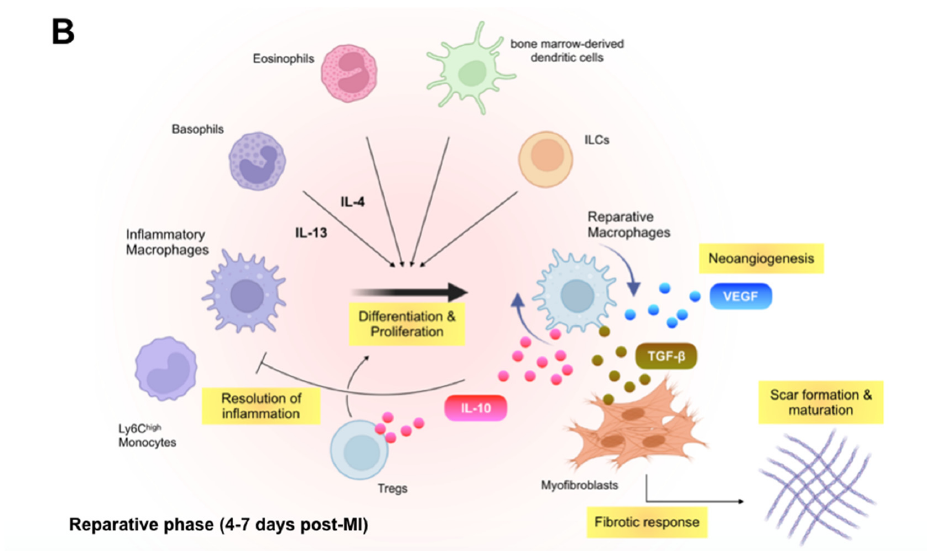
Figure 1. Immune inflammatory response within the infarcted heart. ( A ): Shortly after the onset of myocardial infarction (MI), endogenous damage-associated molecular patterns (DAMPs) released from necrotic cardiomyocytes and other injured cells stimulate surviving resident cells and recruited immune cells to produce inflammatory cytokines, chemokines, and proteases (e.g., interleukin [IL]-1 β , C-C motif chemokine ligand 2 [CCL2], and matrix metalloproteinases), which initiate innate immune response. Inflammatory macrophages scavenge dying cardiomyocyte-derived DNA fragments to activate interferon regulatory factor 3 (IRF3)-dependent type I interferon (IFN) signals that enhance infarct inflammation. Cardiac fibroblasts produce and release granulocyte-macrophage colony-stimulating factor (GM-CSF) in response to the engagement of their pattern recognition receptors (PRRs), which not only endows monocytes and macrophages with a pro-inflammatory signature but also stimulates bone marrow hematopoiesis. B cell-derived CCL7 further enhance monocyte accumulation in the infarcted heart. ( B ): In the later phase of ischemic injury, inflammatory macrophages convert their features to the anti-inflammatory phenotype. The transition is supported partly by regulatory T cells (Tregs), basophils, eosinophils, dendritic cells, and innate lymphoid cells (ILCs) and defines the reparative response in the wound healing process. Reparative macrophages as well as Tregs produce anti-inflammatory cytokines (e.g., IL-10) that resolve inflammation. The reparative macrophages likewise produce transforming growth factor (TGF)- β and vascular endothelial growth factor (VEGF), thereby promoting angiogenesis, fibrosis, and scar